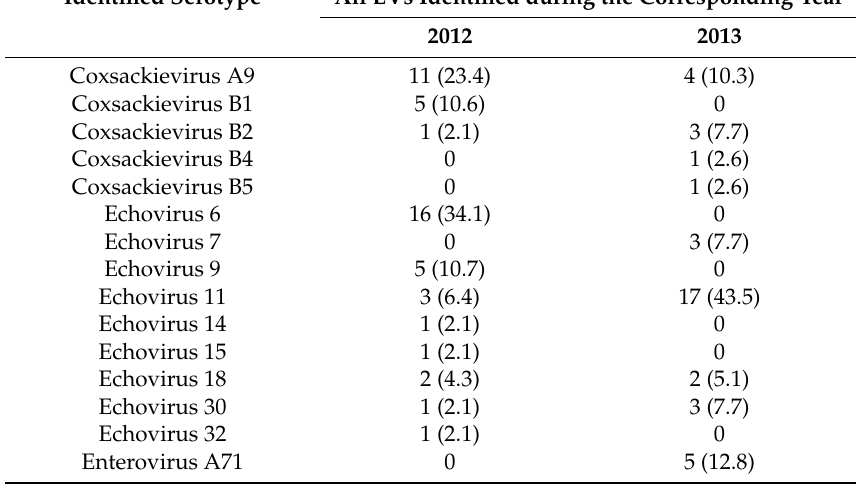
Table 3. Number of enterovirus serotypes identified in patients with meningitis through direct serotyping in